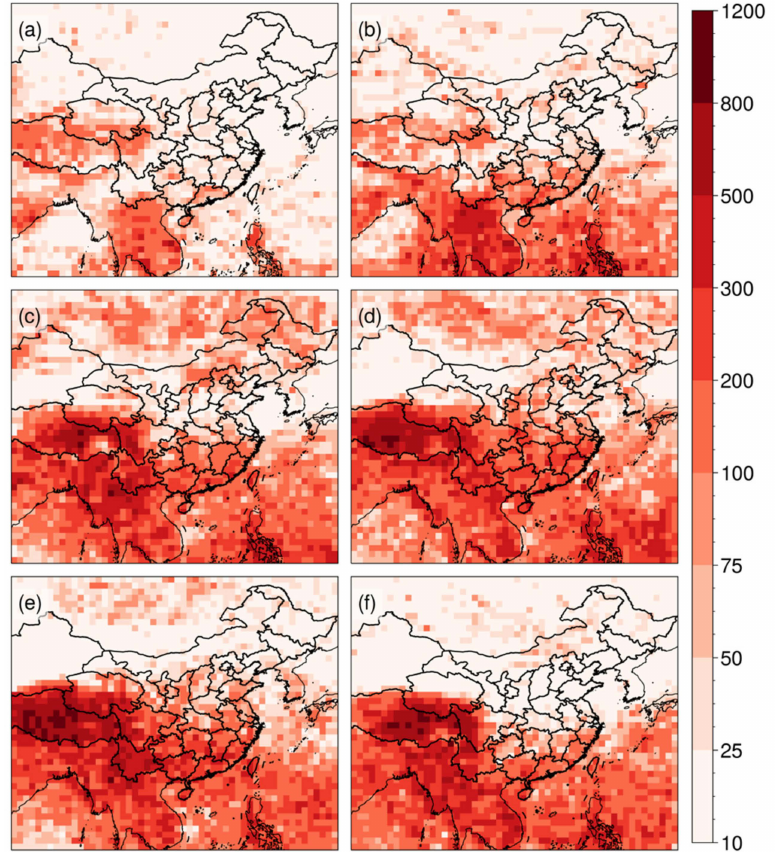
Figure 4. Density of the convective systems identified (number per 1 × 1 degree latitude) on 1 ◦ × 1 ◦ grids during ( a ) April ( b ) May ( c ) June ( d ) July ( e ) August and ( f ) September during